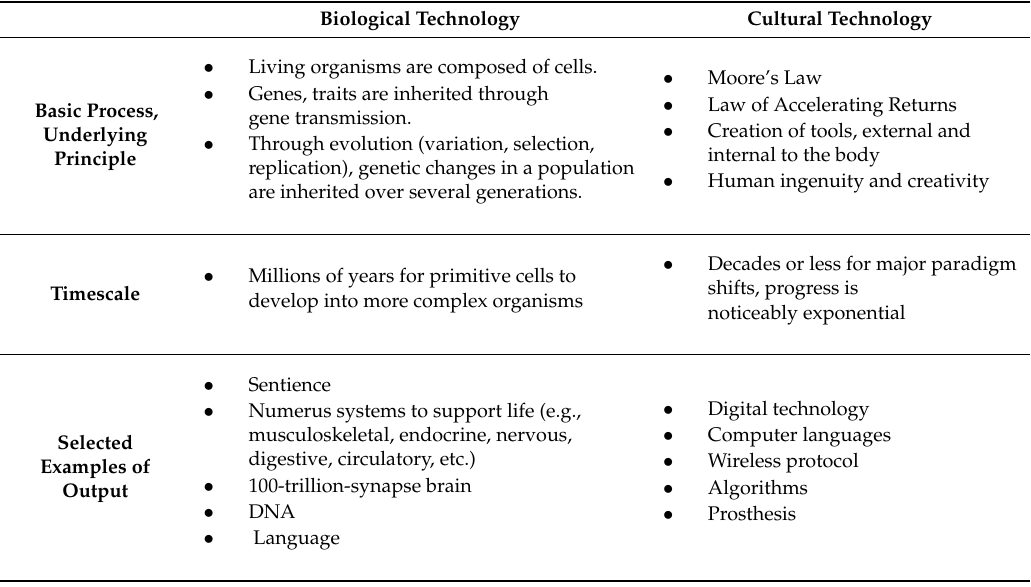
Table 1. Comparison of biological versus cultural